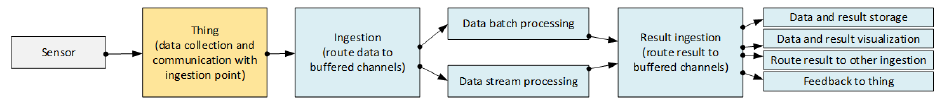
Figure 1. General structure of data pipelines in fault diagnosis.